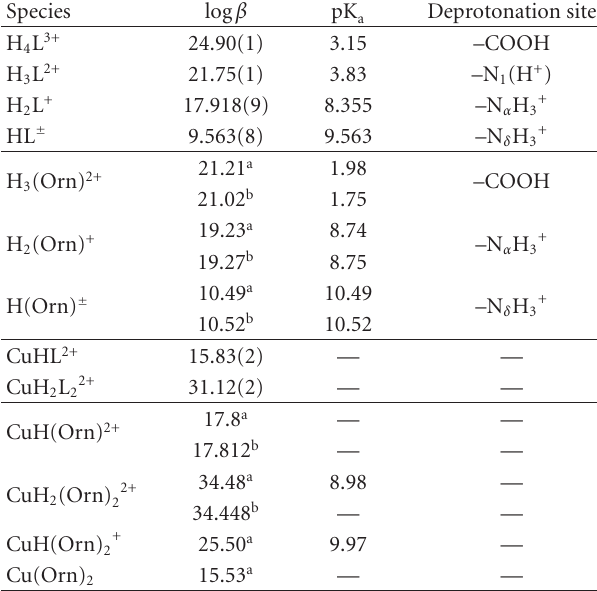
Table 1: The protonation constants of sinefungin (L) and the stabil- ity constants of its Cu(II) complexes with the process sites indicated. The analogous values for ornithine are included for